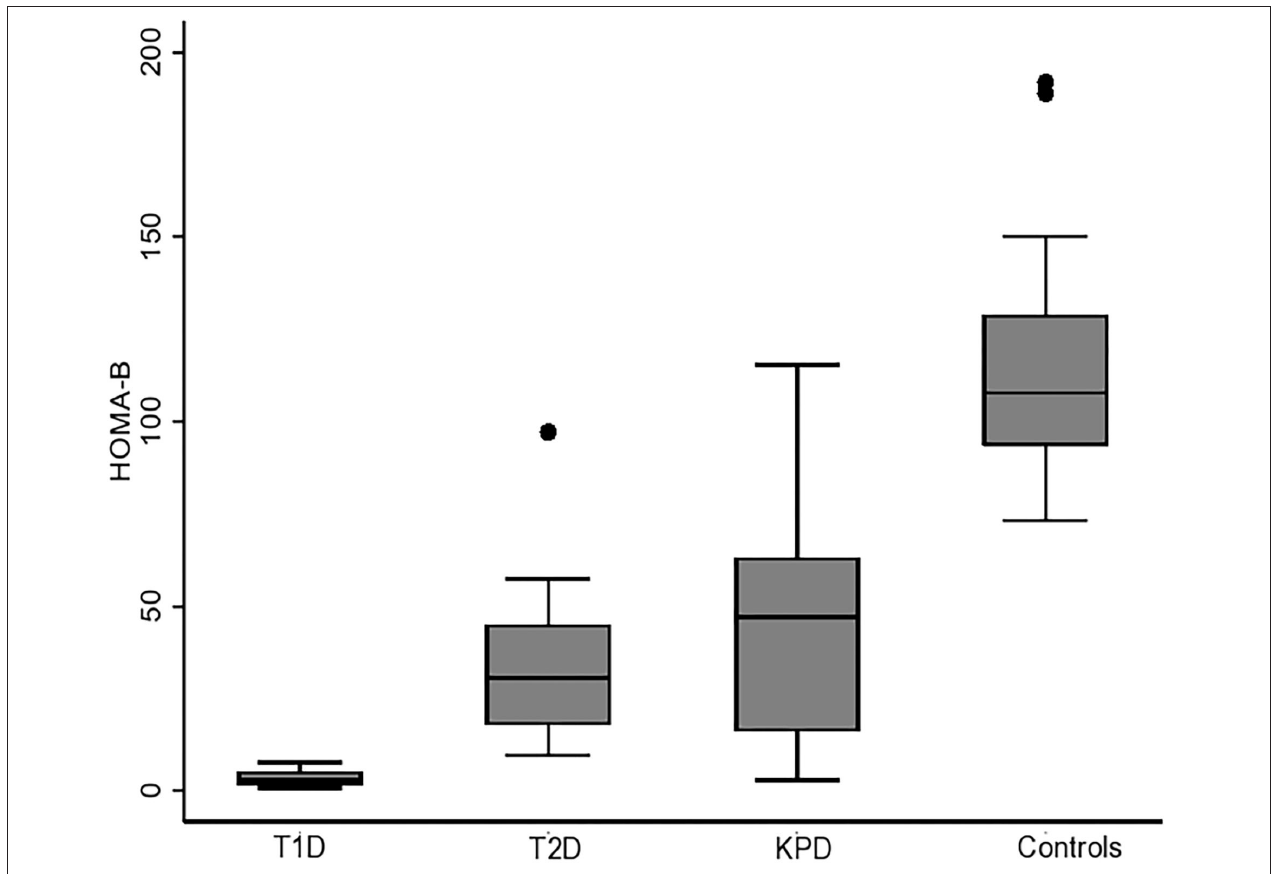
FIGURE 2 | Boxplot showing HOMA- β (beta cell function) in the different categories of participants. The error bars represent the standard errors.